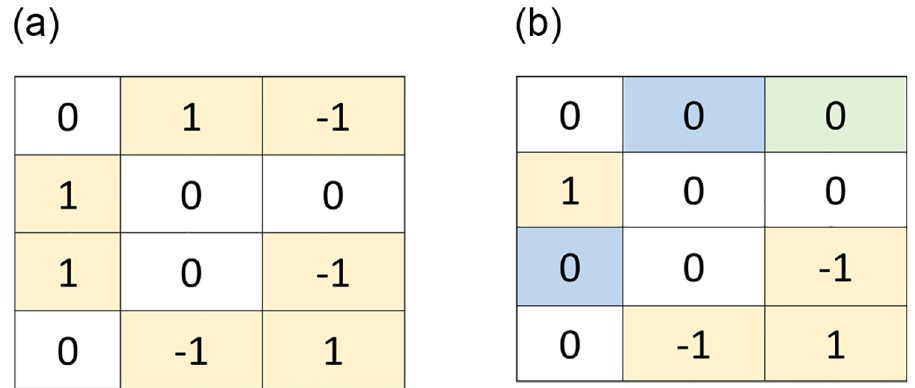
Fig 3. Restoration ability of backward embedding: The changes in pixel values after (a) forward embedding ( yellow cells ) and (b) backward embedding ( blue & green cells ).